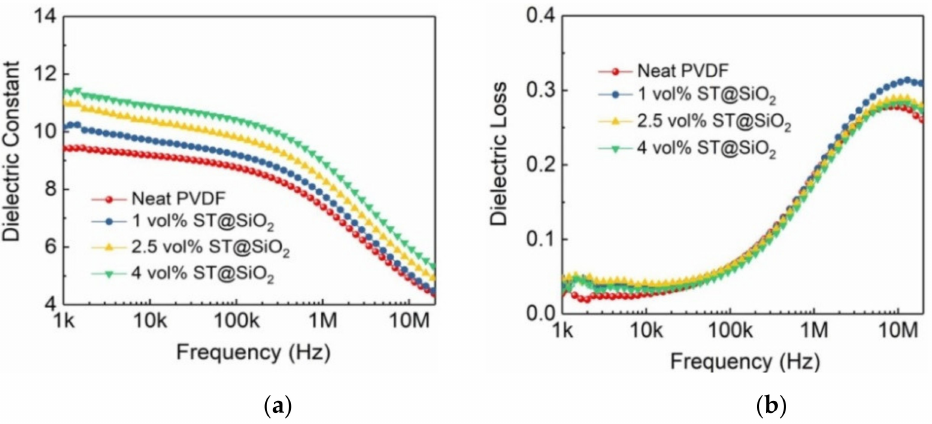
Figure 3. ( a ) Dielectric constant as a function of frequency, ( b ) dielectric loss as a function of frequency of PVDF and composites with SrTiO 3 @SiO 2